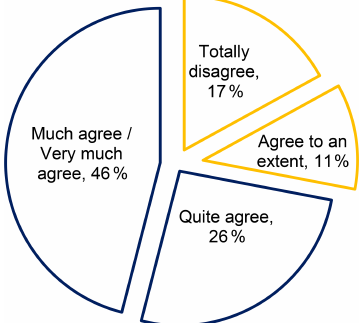
Figure 4. Agreement with the statement that earthquake prepared- ness is a religious obligation enforced by the directive that one must guard one’s own life